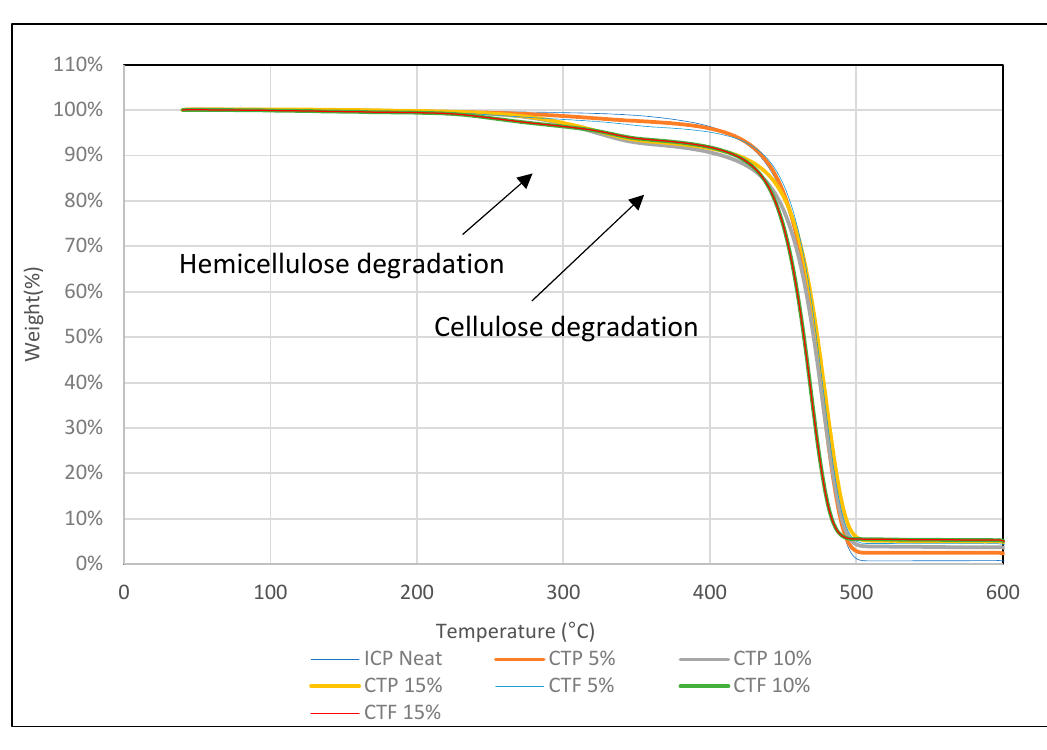
Figure 13. TGA of ICP-treated fiber composites.